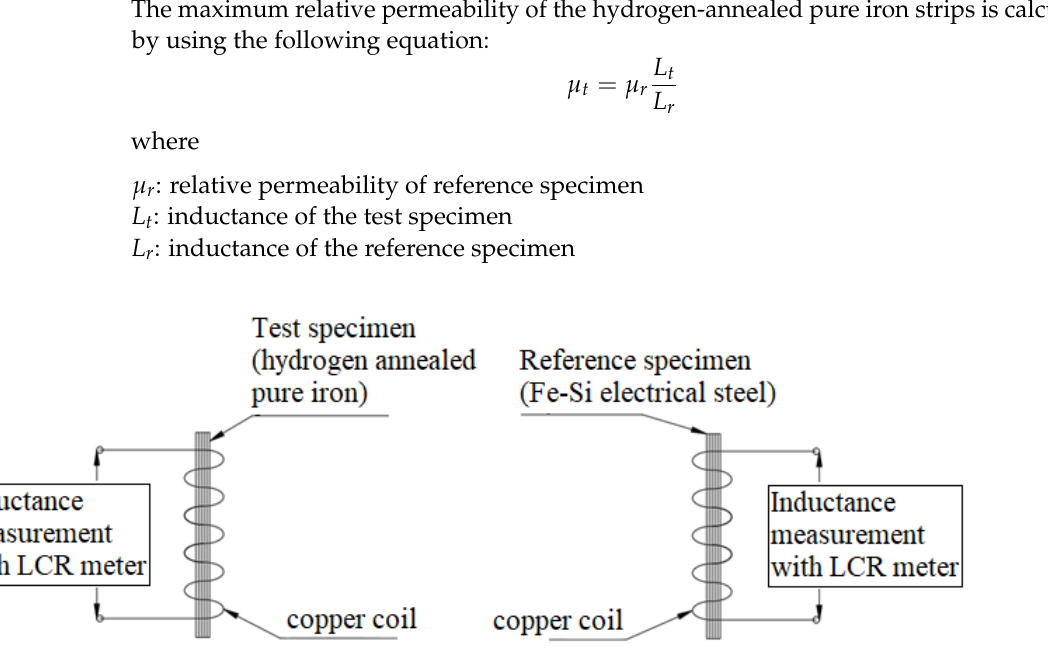
Figure 10. Illustration of the arrangement in the special cooling fixture.